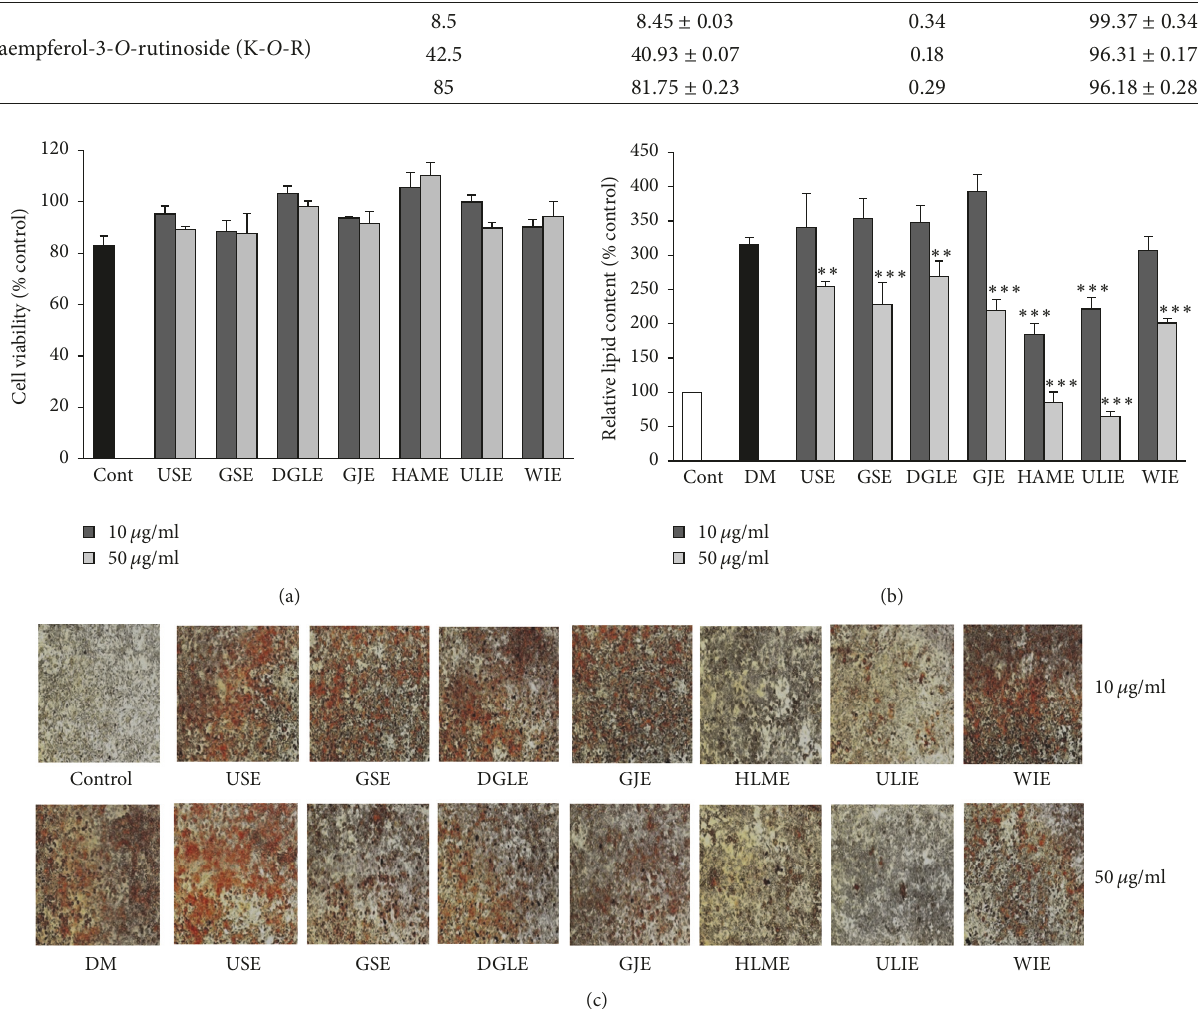
Figure 2: Antiadipogenesis effect on 3T3-L1 of SV extracts collected from different regions. (a) Effect of SV extracts at 10 and 50 𝜇 g/ml on viabilities of 3T3-L1 cells determined by MTS assay for 24 h; (b) relative lipid content, quantified by absorbance in 3T3-L1 cells with or without SV extracts at 10 and 50 𝜇 g/mL for 8 days; (c) Oil Red O staining of lipid droplets in 3T3-L1 cells with or without SV extracts at 10 and 50 𝜇 g/mL for 8 days. Results are presented mean ± SE. The asterisk indicates a significant difference compared to DM ( ∗∗ 𝑃 < 0.01 and ∗∗∗ 𝑃 < 0.001